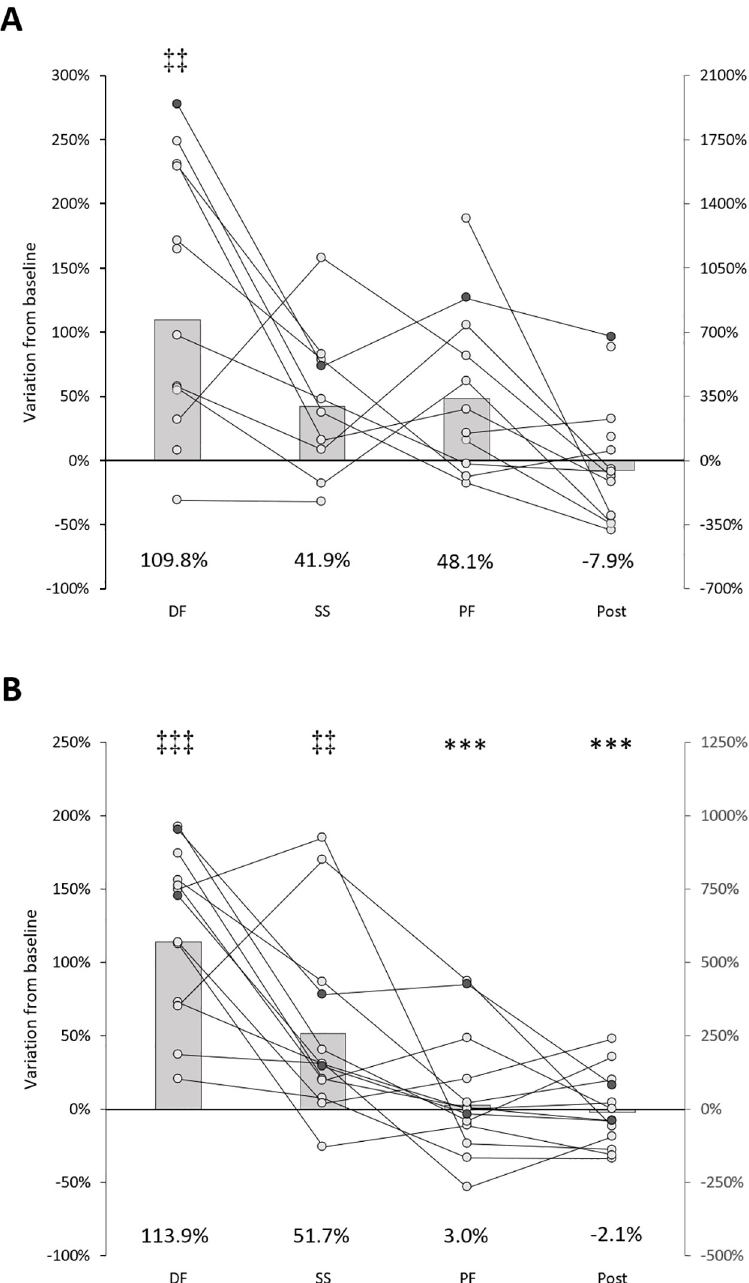
Fig 4. A: SOL; B: TA. On the primary axis, bars: Group average MEPs amplitude expressed as percentage of baseline values (with data labels); connected dots: Invidividual values. On the secondary axis are plotted the individual subjects represented with thicker lines and filled circles (for graphical reasons these values were not included for computing the group average bars). Comparison to DF: *** p < .005; Comparison to baseline: ‡‡ p < .01; ‡‡‡ p < .001.